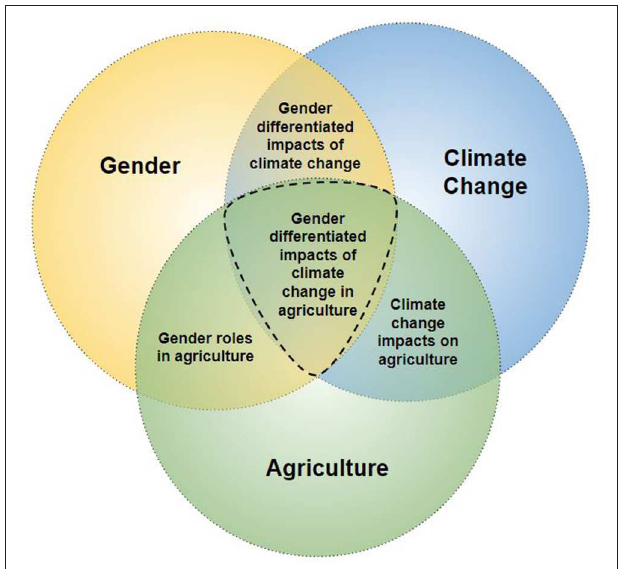
FIGURE 1 | Conceptual diagram to define the gender-agriculture-climate change nexus.